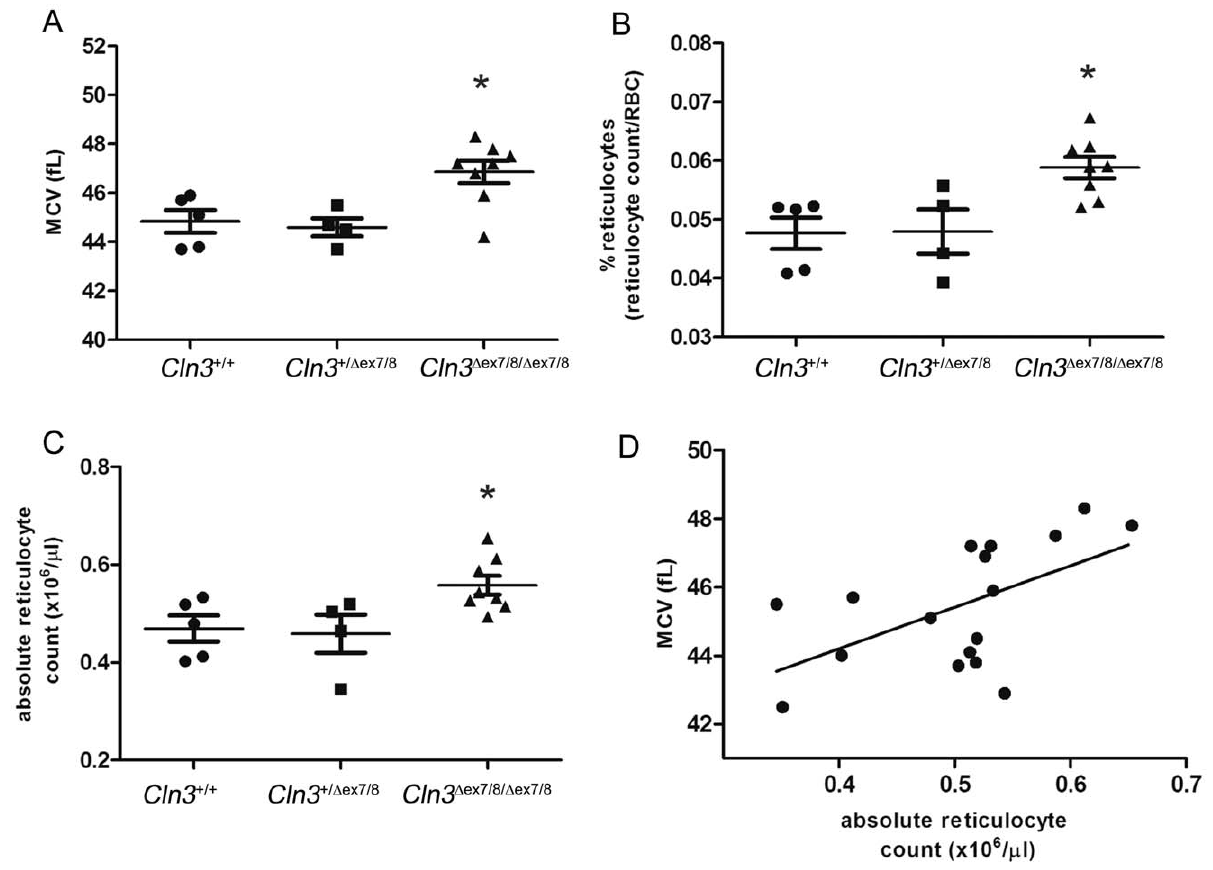
Figure 5. Abnormal hematology in peripheral blood from homozygous Cln3 D ex7/8 mice. (A) Mean corpuscular volume (MCV, fL) of peripheral red blood cells from , 12-week-old mice was measured on an automated analyzer. *, p , 0.05, WT and heterozygous mutant mice vs. homozygous mutant mice, unpaired, two-tailed t test. Data shown as mean 6 SEM. Percentage of reticulocytes (B) and absolute reticulocyte counts (C) on the specimens analyzed in (A) were determined manually by new methylene blue staining. *, p , 0.05, WT and heterozygous mutant mice vs. homozygous mutant mice, unpaired, two-tailed t test. Data shown as mean 6 SEM. (D) Linear regression analysis of data from (A) and (C). r 2 =0.32, p=0.02. Datapoints represent individual mice.